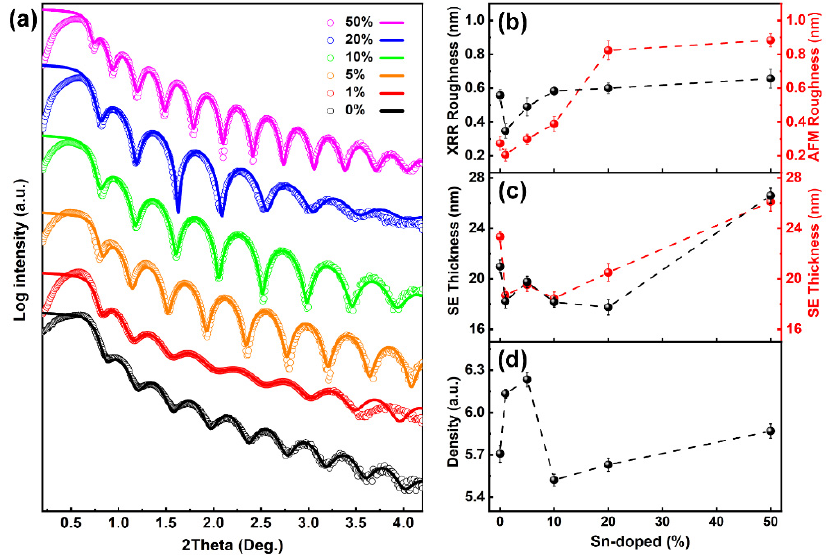
Figure 5. ( a ) Measured XRR (hollow cycle) for the Ga 2 O 3 film with different Sn concentrations com ‐ pared to the simulated data (curves). ( b ) The RMS roughness, ( c ) the thickness, and ( d ) the density of the film with variation in the Sn